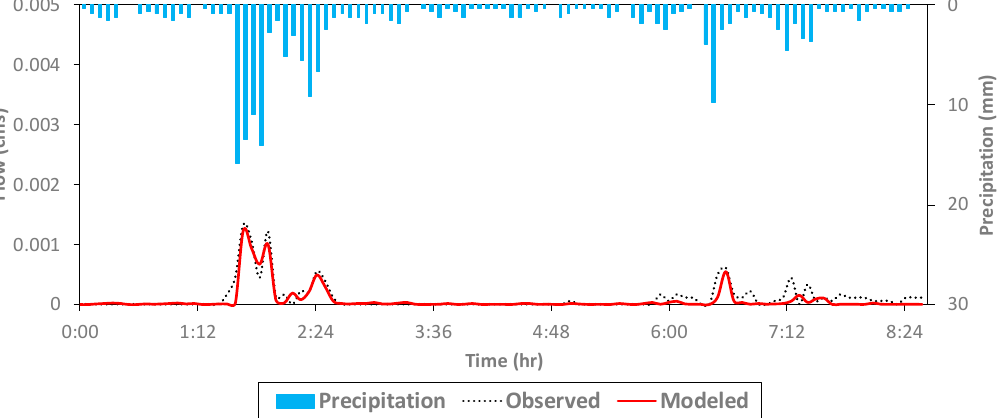
Figure 12. Default weights for different criteria in BMP selection module.